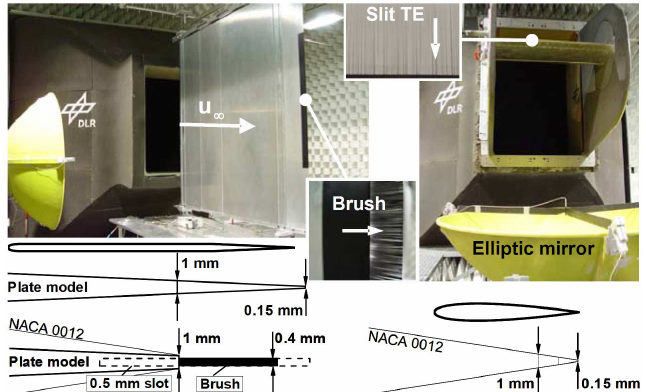
Figure 14. Experimental setups in the AWB test section with example of trailing edge brush or slit devices, reprinted from [148] with permission from